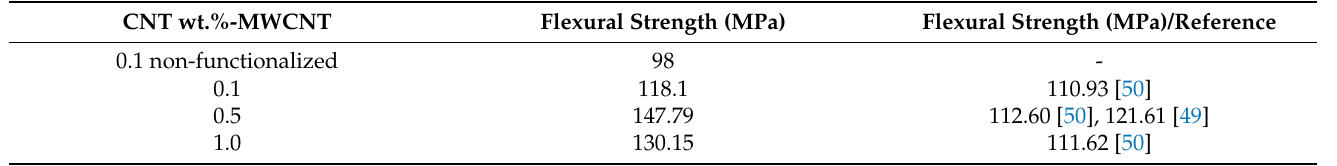
Table 6. Comparison of flexural strength of MWCNT-reinforced PMMA nanocomposites. CNT